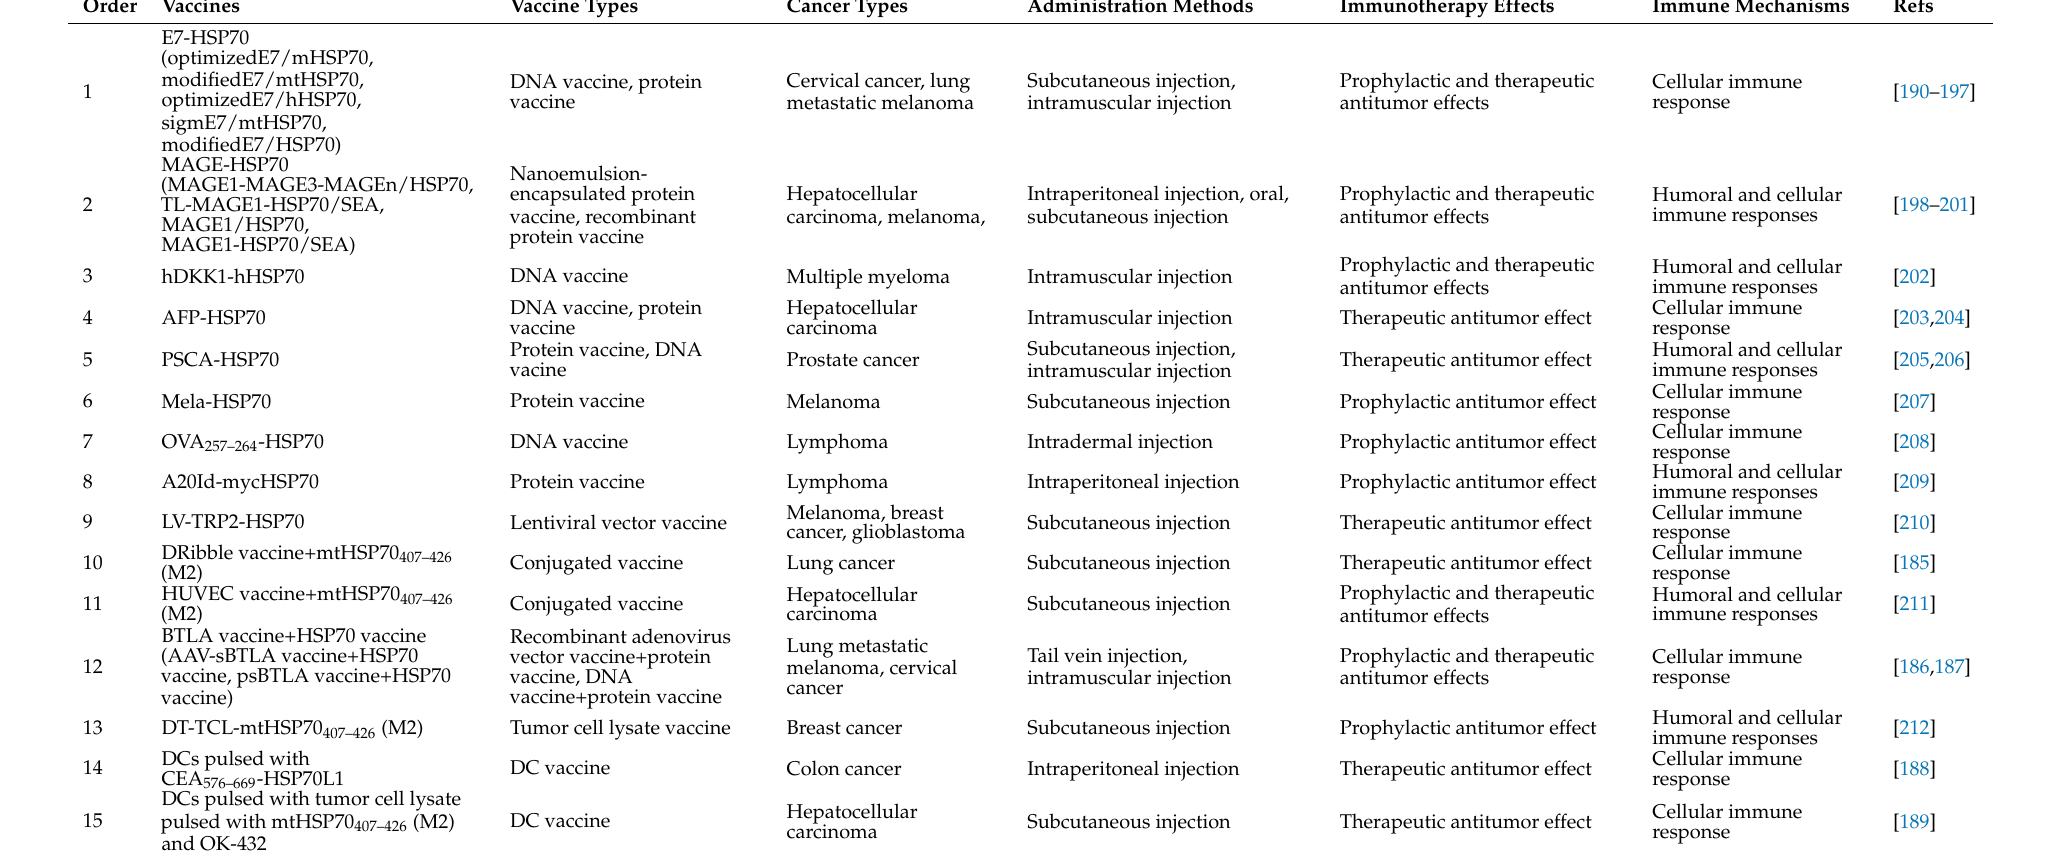
Table 2. Preclinical studies of HSP70-based vaccines in cancer